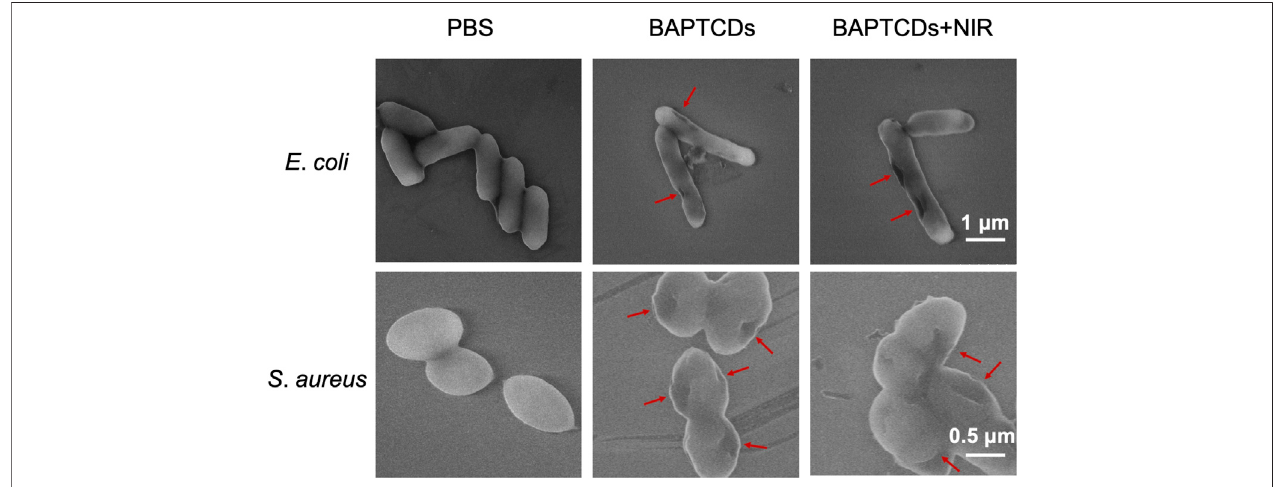
FIGURE 9 | SEM images of E. coli ATCC 700926and S. aureus ATCC 29213were treated by using BAPTCDs at 200 μ g/ml with or without NIR. (808 nm with the power density of 1.5 W/cm 2 ). The red arrow shows where the bacterial cell wall has